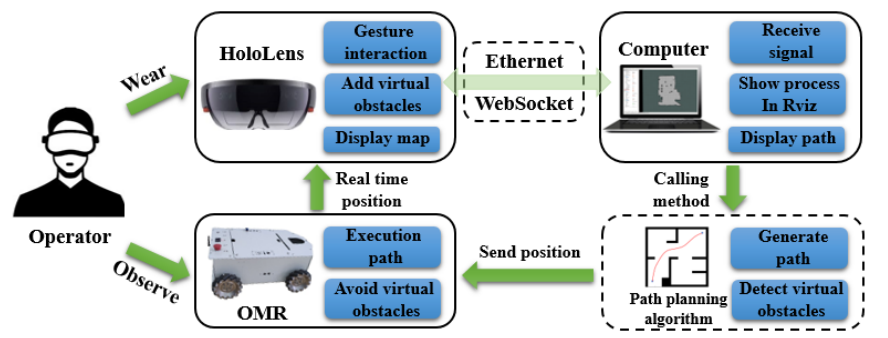
Figure 1. Diagram for the system of